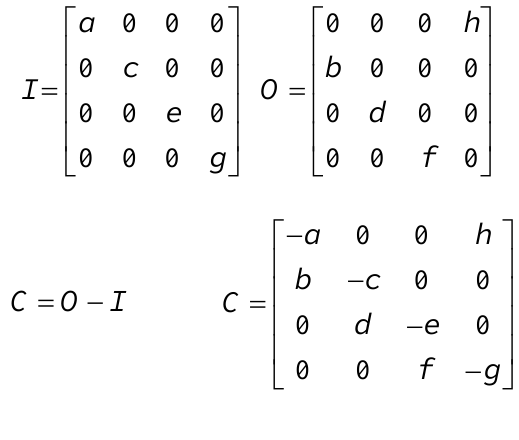
Fig. 1. A basic Petri net